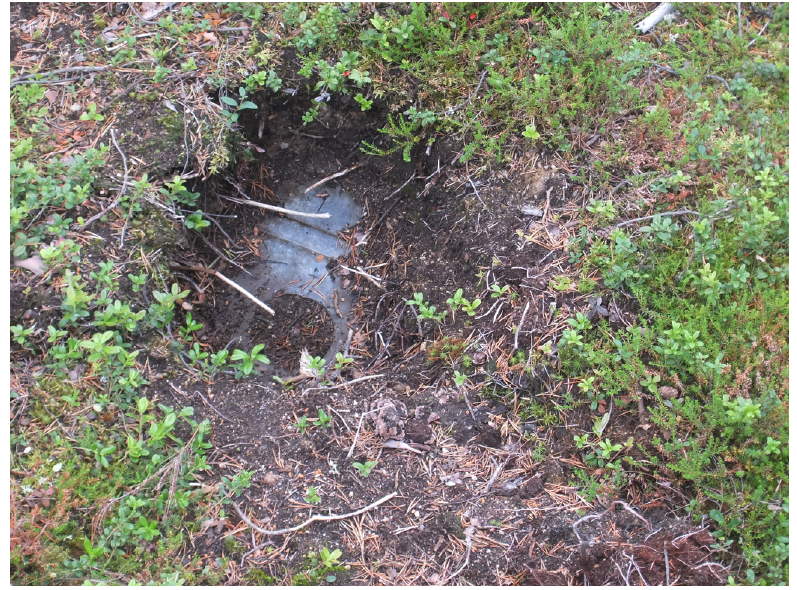
Fig. 3. Recent evidence of unauthorized digging at a Second World War site close to Inari, Finnish Lapland. Photograph by Suzie